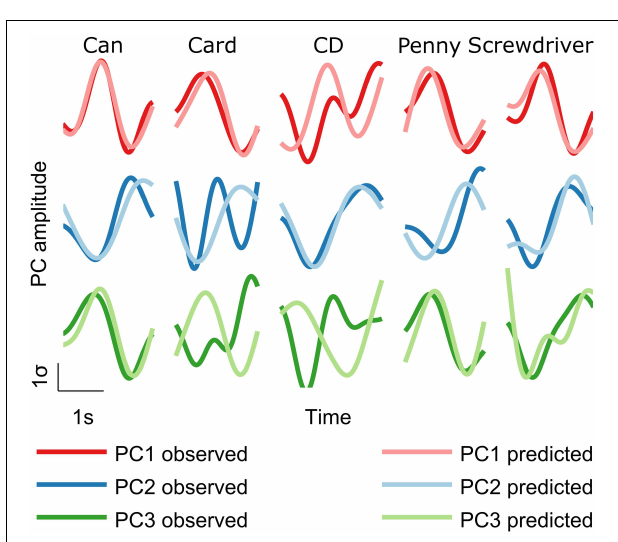
FIGURE 4 | Decoded trajectories. Predicted trajectories (light traces) showed similarity with measured trajectories (heavy traces). Examples of decoded PC trajectories for each object are shown for subject